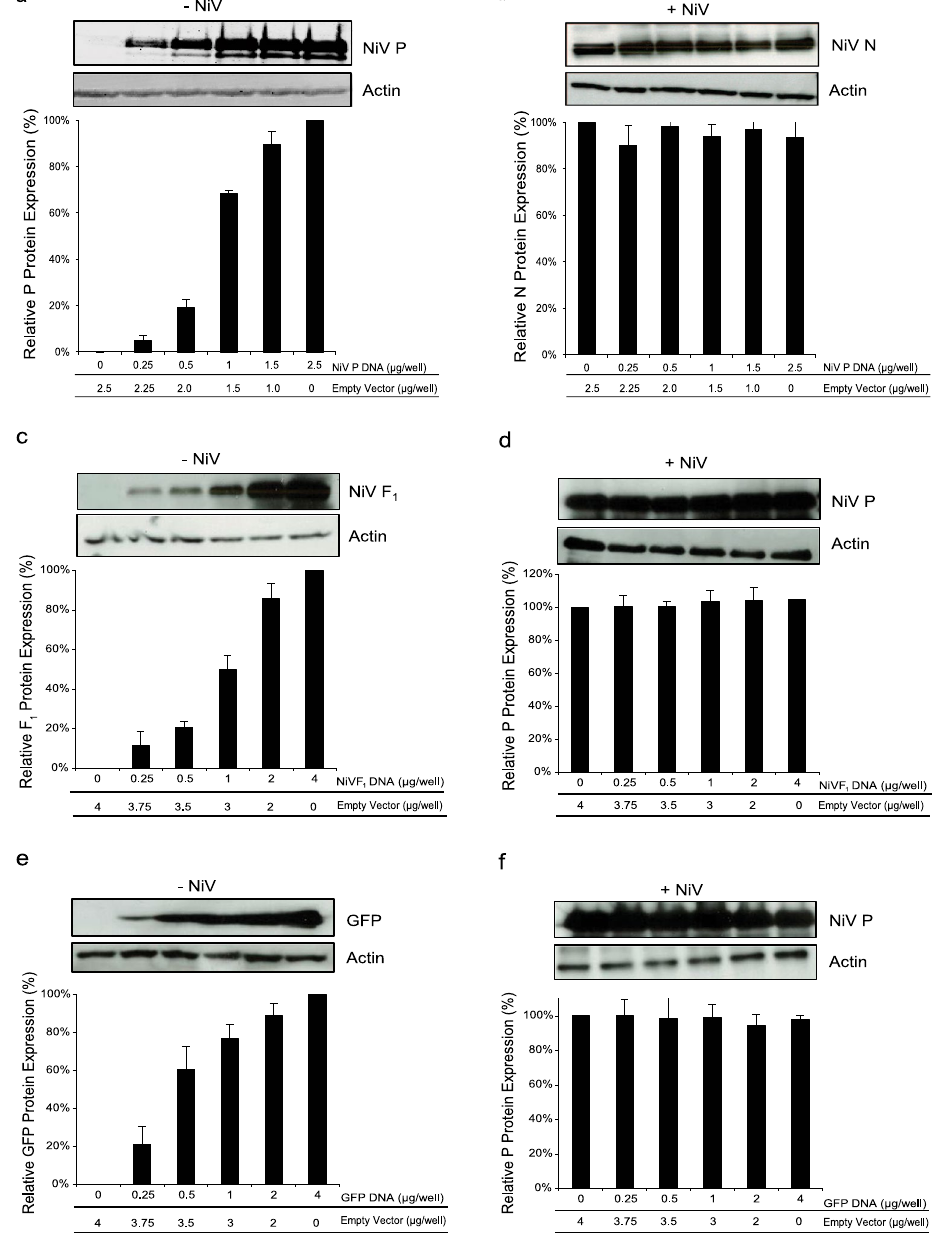
Figure 2. Effects of increasing expression of recombinant proteins on viral translation. Cells were transfected with increasing amounts of plasmid DNA encoding the ( a ) NiV P gene, ( c ) NiV F gene, or ( e ) GFP gene. 48 hours post transfection, cells were harvested and analyzed by western blot. Protein expression was quantified by densitometry and normalized to actin. Following transfection, a parallel set of cells were infected with NiV at an MOI of 1 for 24 hours. Total protein was harvested from NiV infected cells and analyzed by western blot for the expression of ( b ) NiV N proteins or ( d ) and ( f ) NiV P proteins. Western blots were quantified by densitometry and normalized to actin. All experiments were performed in triplicate and standard deviations of the mean were calculated. Blots have been cropped to ease